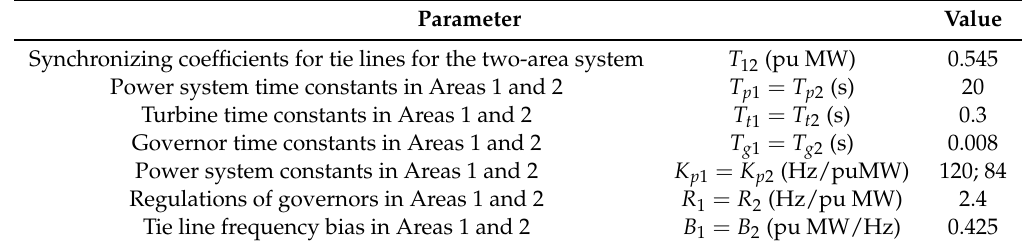
Table 1. Parameters used.